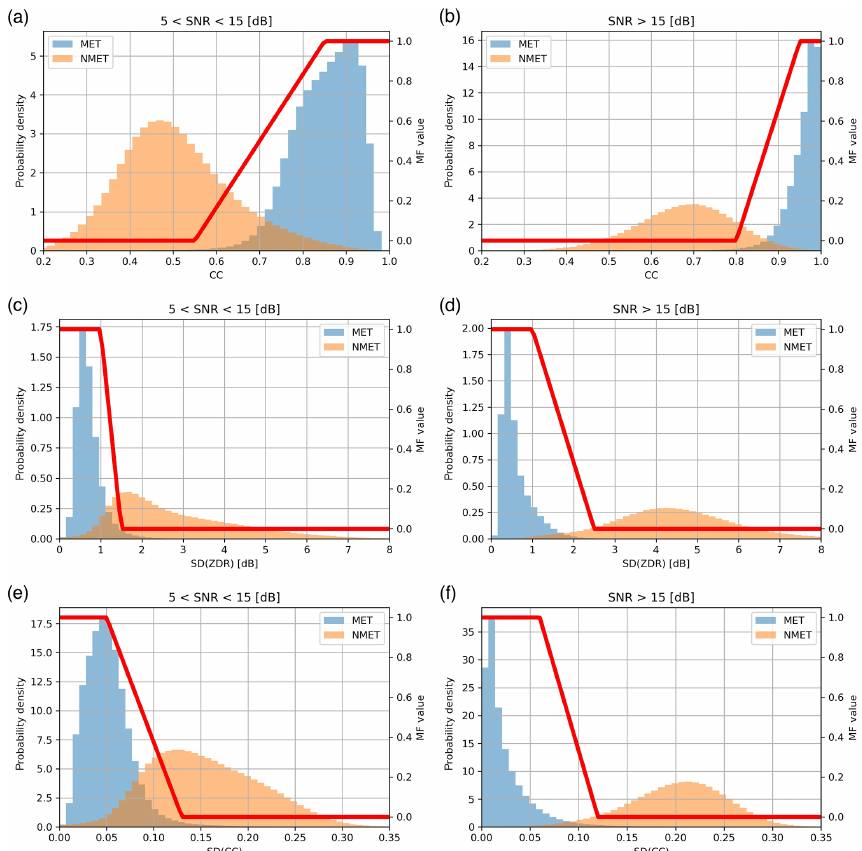
Figure 9. The normalized frequency distributions and membership functions of polarimetric features stratified by SNR: (a) CC (5 < SNR < 15dB), (b) CC (SNR > 15dB), (c) SD(ZDR) (5 < SNR < 15dB), (d) SD(ZDR) (SNR > 15dB), (e) SD(CC) (5 < SNR < 15dB), and (f) SD(CC) (SNR >